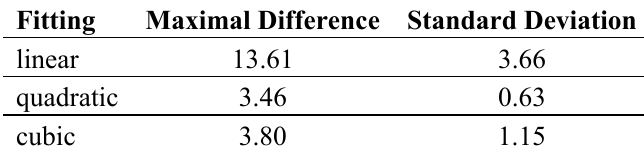
Table 2. Statistics of the compensated results